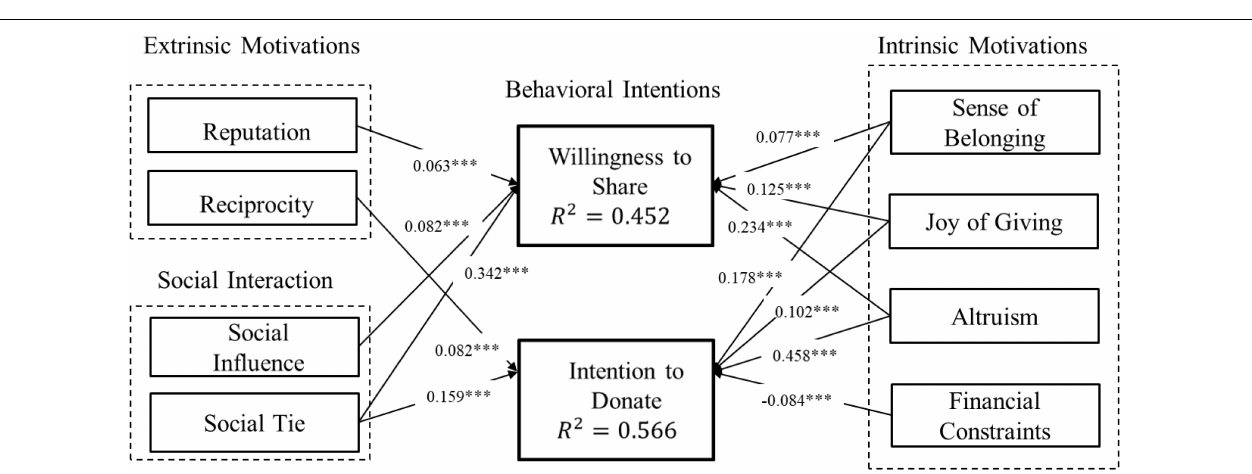
FIGURE 3 | Results of structural model. *** p <